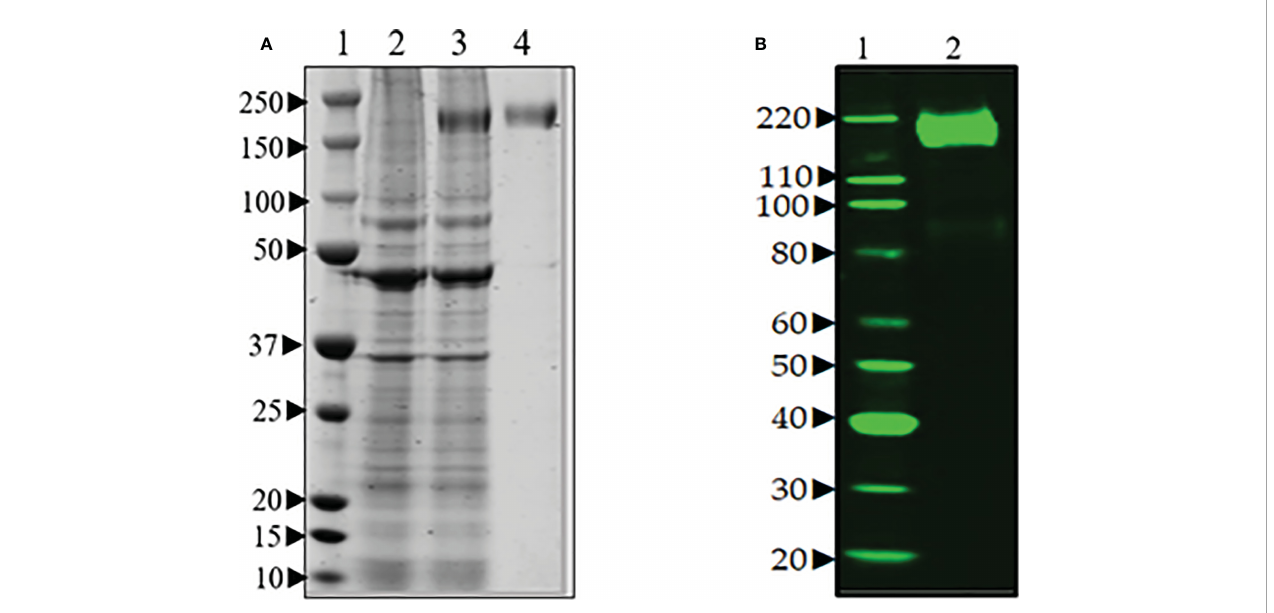
FIGURE 2 (A) SDS-PAGE of transient production of recombinant spike protein in Expi293F cells transfected with plasmid encoding spike gene under optimized conditions. Lane 1. protein marker, Lane 2. supernatant from untransfected cells, Lane 3. supernatant from transfected cells, and Lane 4. puri fi ed spike (~190Da). (B) Western blot analysis of the puri fi ed spike protein with anti-hexa-His tag antibody con fi rmed the expression of spike protein by the Expi293F cells. Lane 1. Magic marker, Lane 2. puri fi ed spike